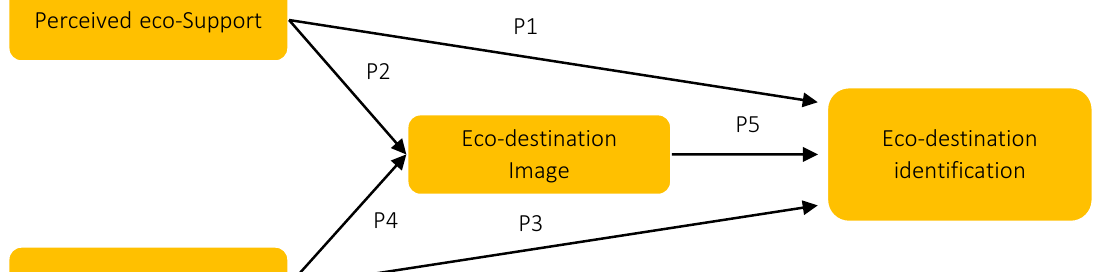
Figure 2. Conceptual